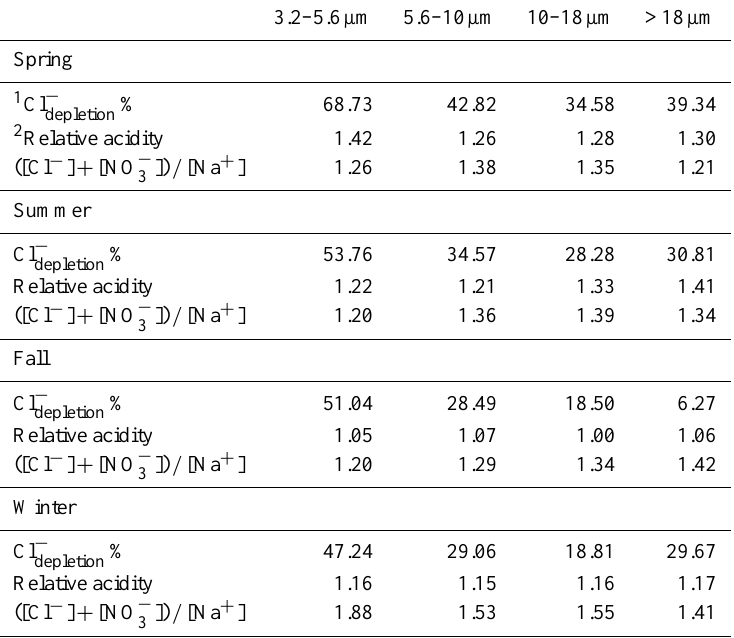
%), relative acidity, and ionic ratios in each depletion